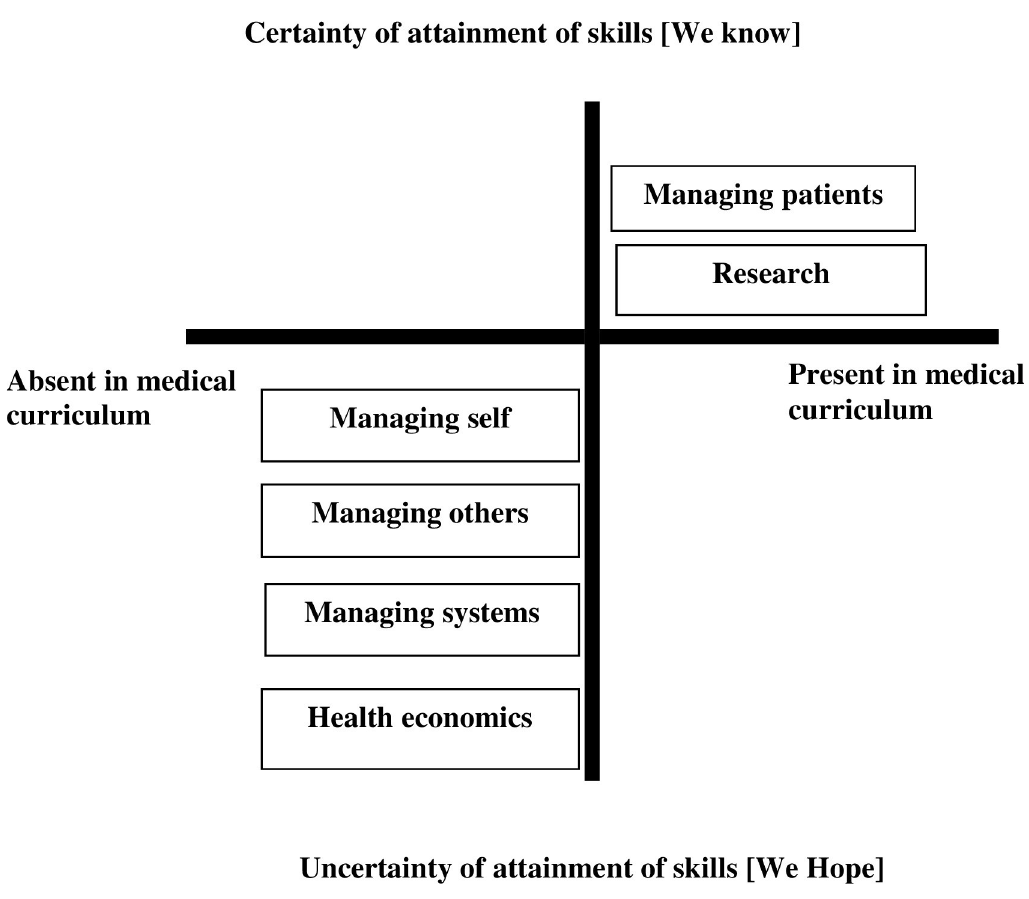
Fig 1. Typology of study